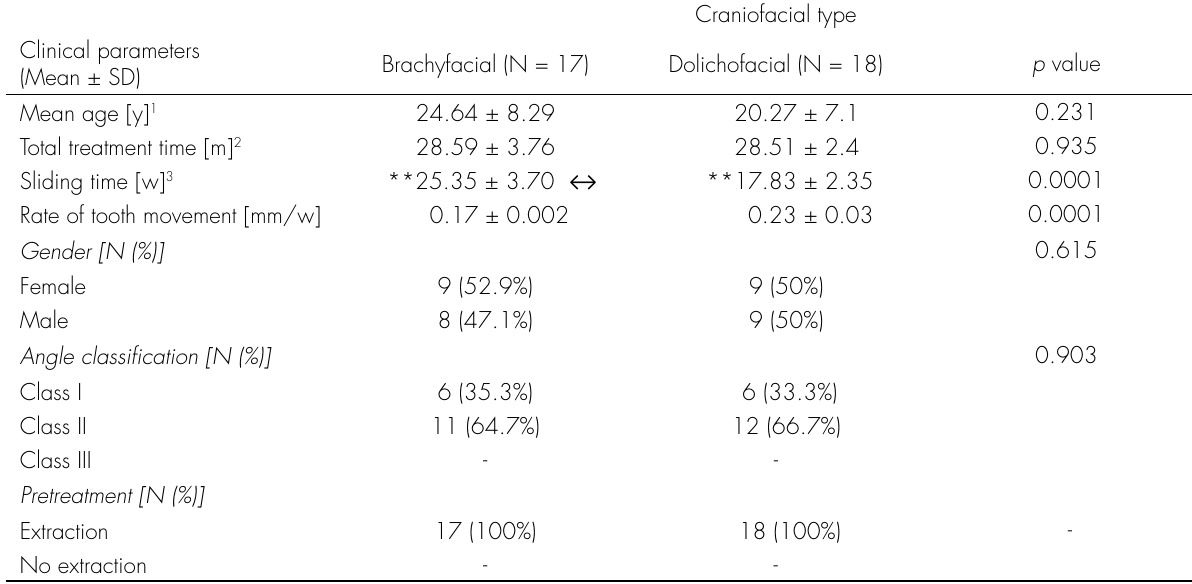
Table I. Clinical parameters of the study patients.